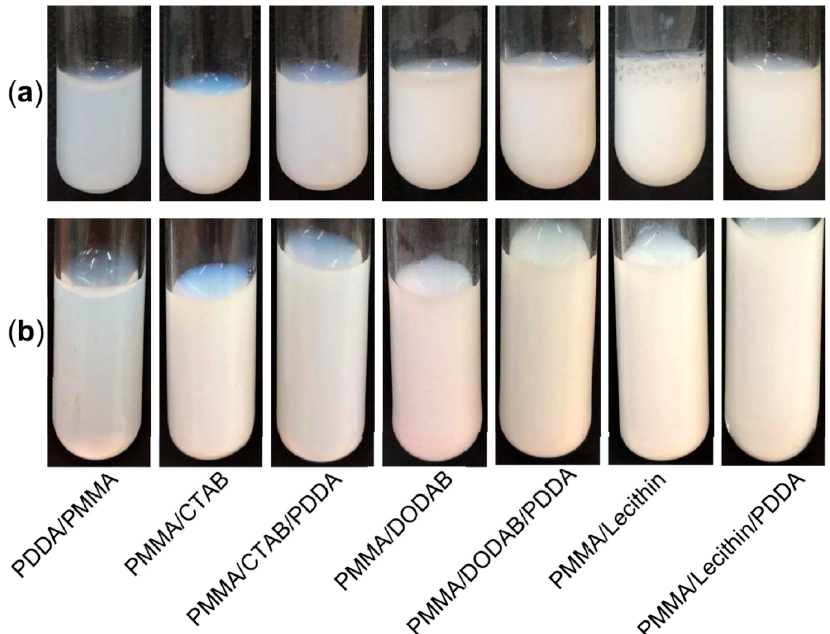
Figure 5. ( a ) Photos of dispersions just after synthesis and dialysis; ( b ) photos of the same dispersions approximately 4 months later. Details on composition and physical properties of the dispersions just after synthesis are on Table 5.